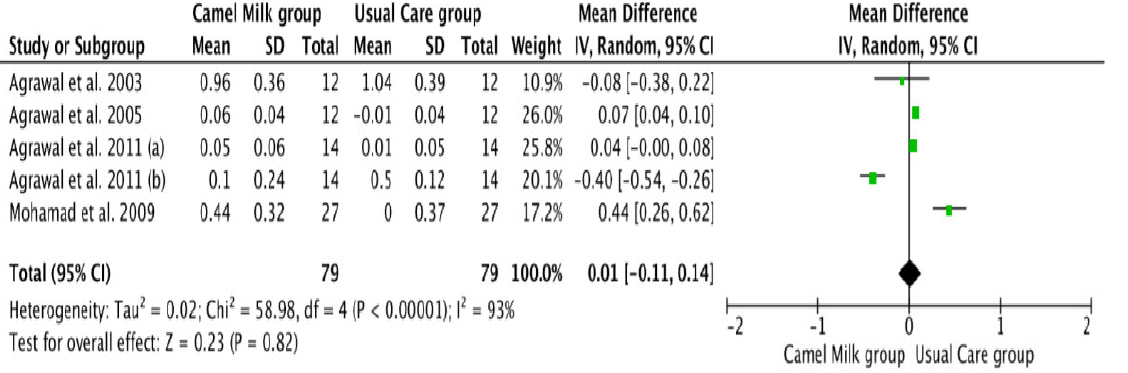
Figure 9. Forest plot for the effect of CM intake on C-peptide (CP). (a) and (b) are two different